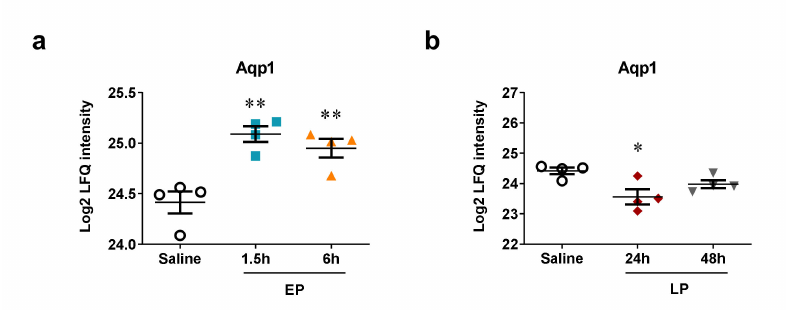
Figure 8. Protein expression of experimentally validated miRNA targets in the kidneys of mice after LPS administration. Log2 transformed label-free quantification (LFQ) intensity values of proteins as determined by mass spectrometry. Left column: EP, right column: LP. ( a , b ) Aquaporin-1 (Aqp1). Data are expressed as mean ± SEM; one-way ANOVA; *: p < 0.05, **: p <